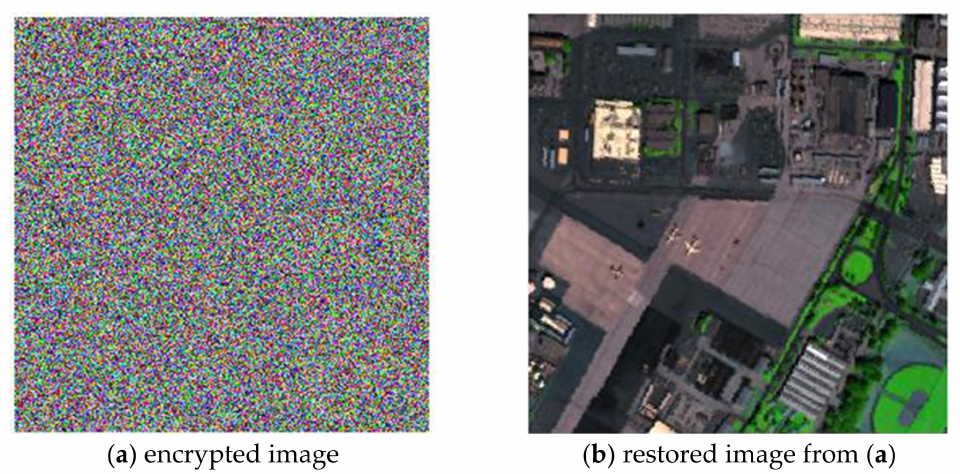
Figure 6. Experimental data: ( a ) final encrypted image combined of 30th, 70th and 100th band; ( b ) decrypted image combined of 30th, 70th and 100th